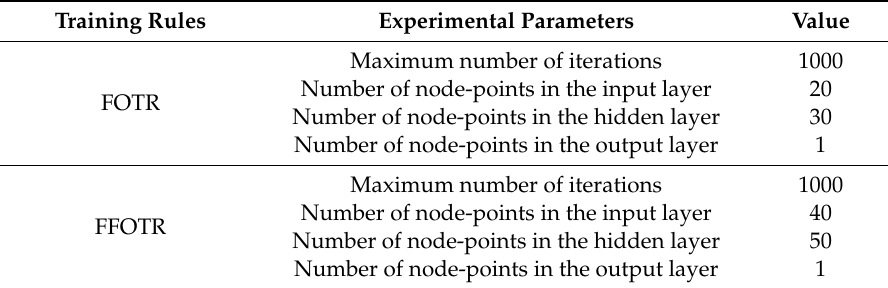
Table 3. Experimental parameters setting in the neural network